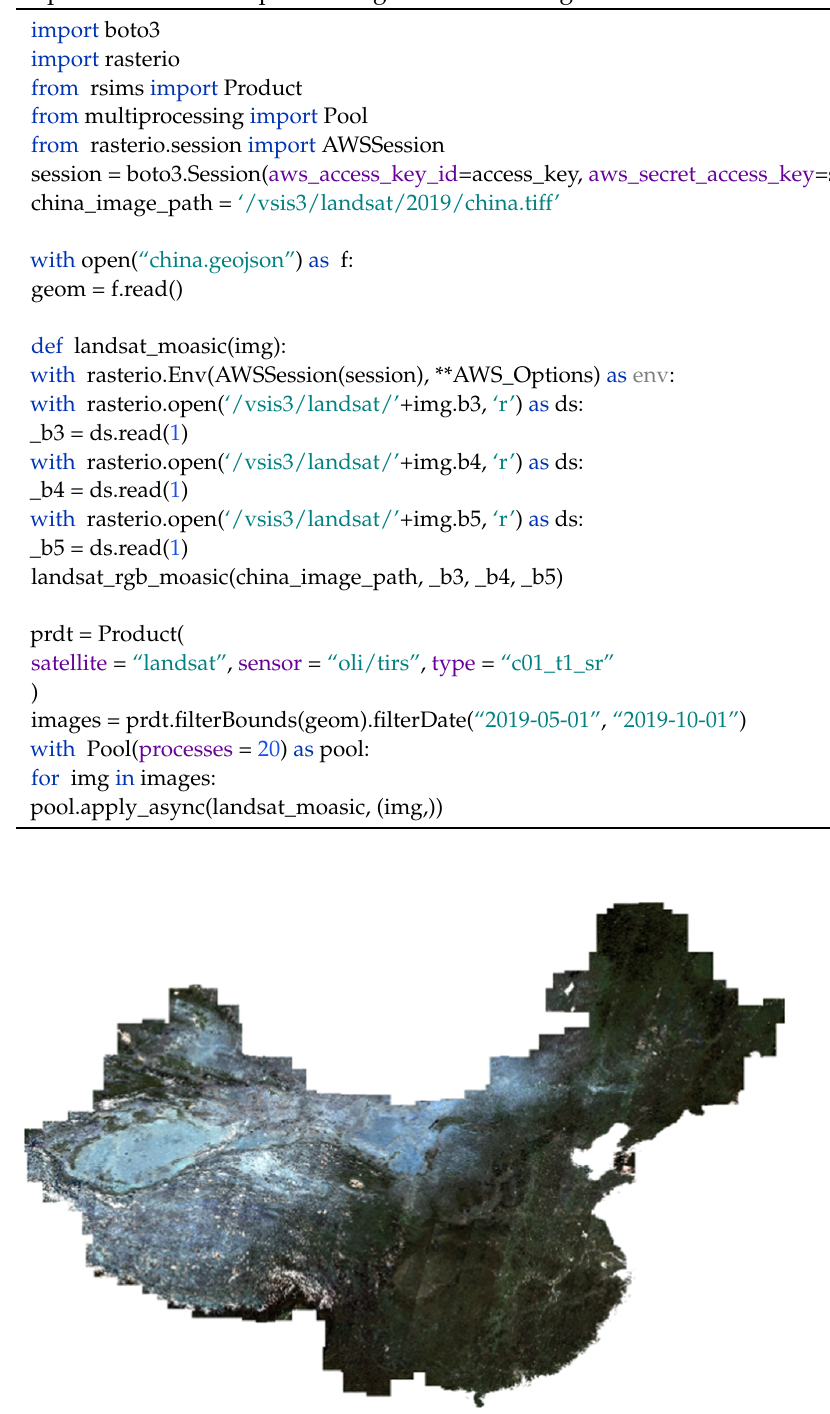
Figure 28. The composite Landsat image of China mainland.